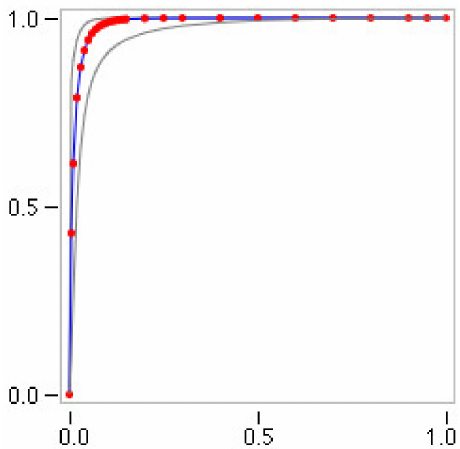
Figure 3. The ROC area of all the trained data: AUC (0.986).